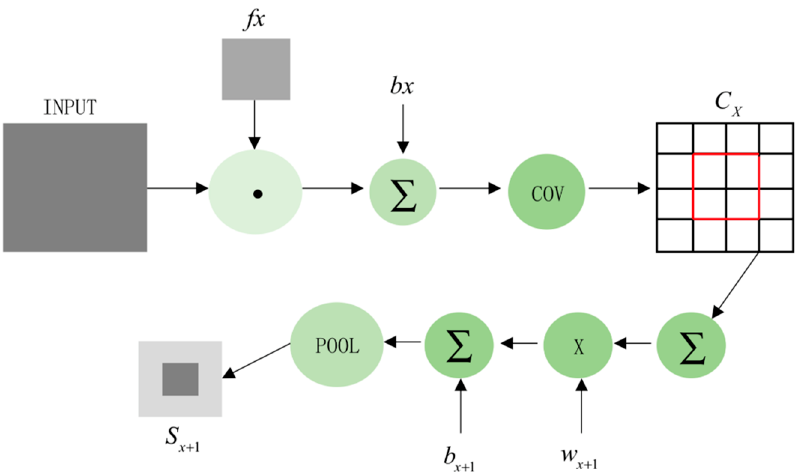
Figure 3. Convolution (COV) and down-sampling operations.